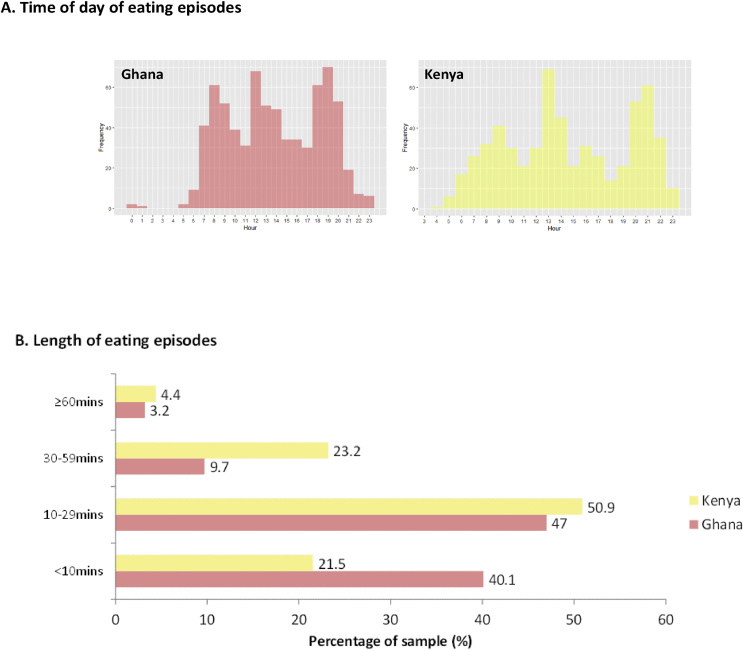
Timing (A) and length (B) of eating episodes.